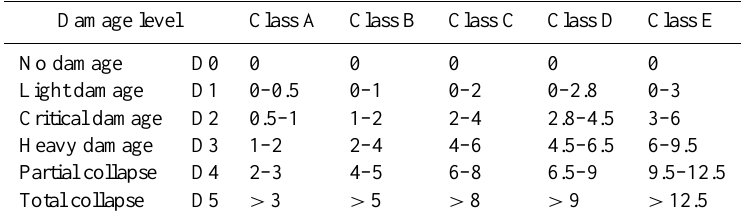
Table 4. Building damage matrix after the project SCHEMA (Valencia et al., 2011) modified in building classes A and B following the fragility curves proposed by Reese et al. (2007). The first column reports the description of the damage level. The columns from A to E give the flow depth intervals in metres. Notice that damage D0 is attributed only to buildings reached by no tsunami waves.